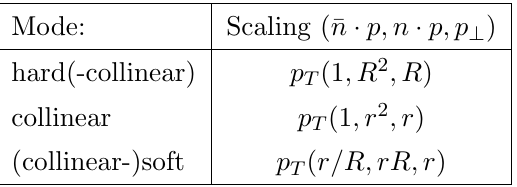
Table 2 . The parametric scalings of the momenta of the modes that enter in the factorization of the jet function for r R (cid:28)